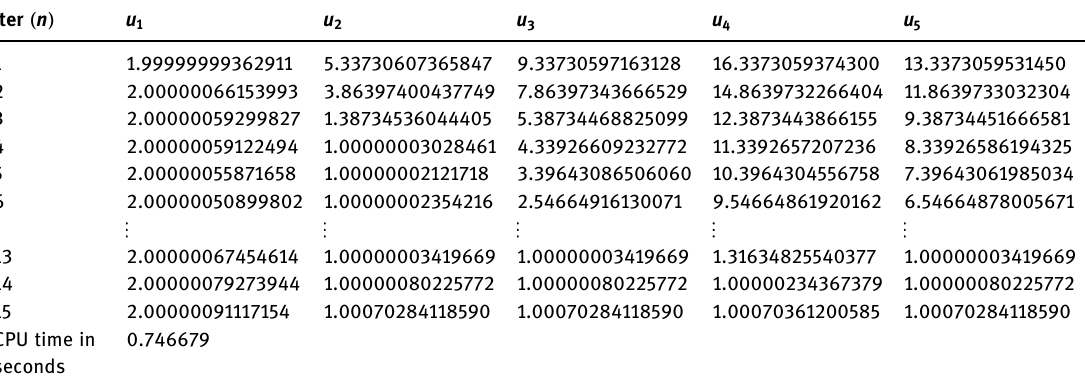
Table 4: Example 5.2: Numerical study of Algorithm 2 with TOL = 10 −4 and u 2, 7, 11, 18, 15 T 0 ( ) = Iter ( n